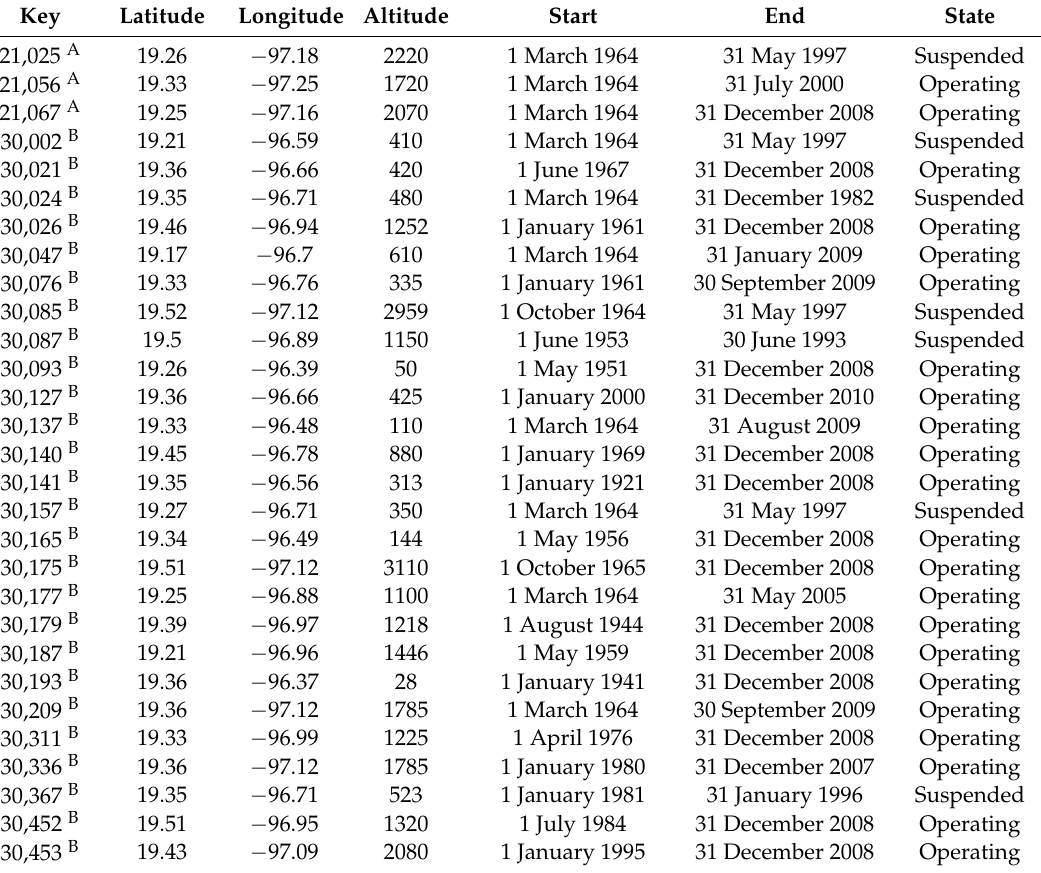
Table 2. Main characteristics of the meteorological stations of the study basin: key meteorological station, geographic coordinates, altitude (m a.s.l.), information time window, and state